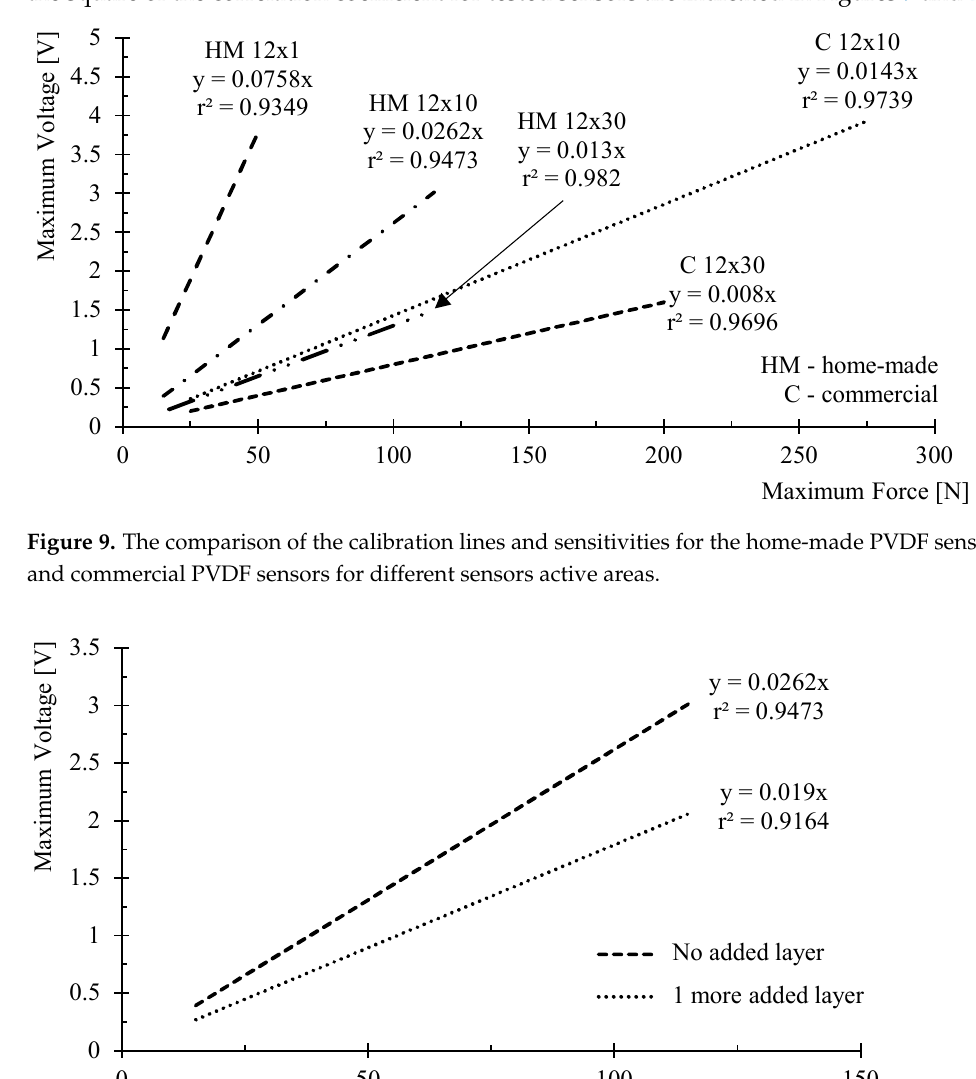
Figure 8. The dependence of the measured maximum voltage (cid:1847) (cid:3040)(cid:3028)(cid:3051) on calculated mean impact force (cid:1832) (cid:3040)(cid:3032)(cid:3028)(cid:3041) for the home-made PVDF sensor (12 mm × 30 mm).